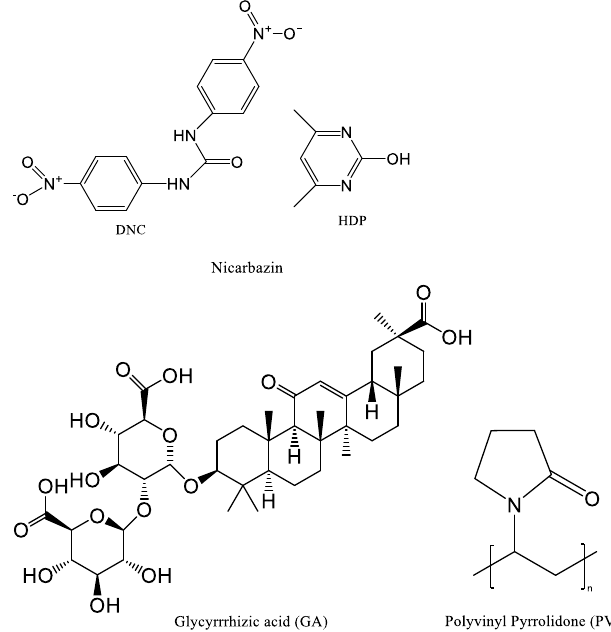
Figure 1. Structure of NIC, GA, and PVP.